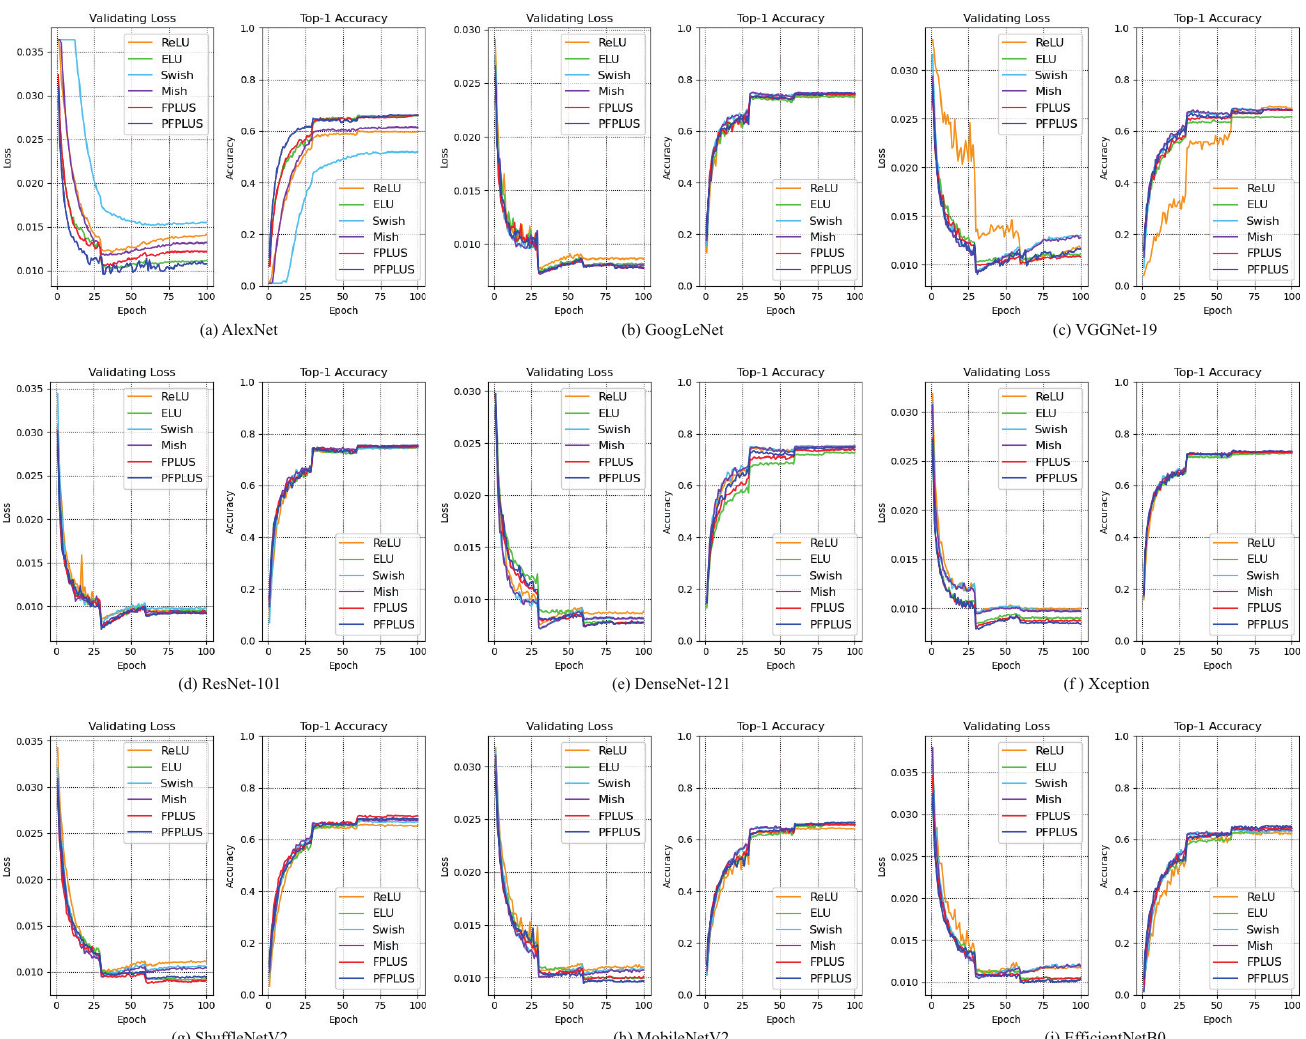
Figure 14. Curves of validating loss and top-1 accuracy for each model activated by different methods. Subfigures ( a – i ) are organized by the type of networks. Every subfigure contains a loss descent record on the left, and an illustration of top-1 accuracy ascent on the